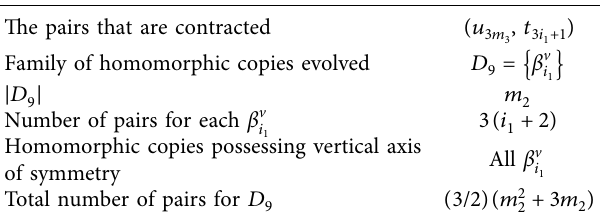
Table 8: Necessary information regarding homomorphic copies 􏽮 􏽯 . β v i 1